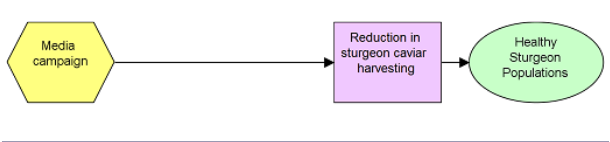
Fig. 4 . Initial results